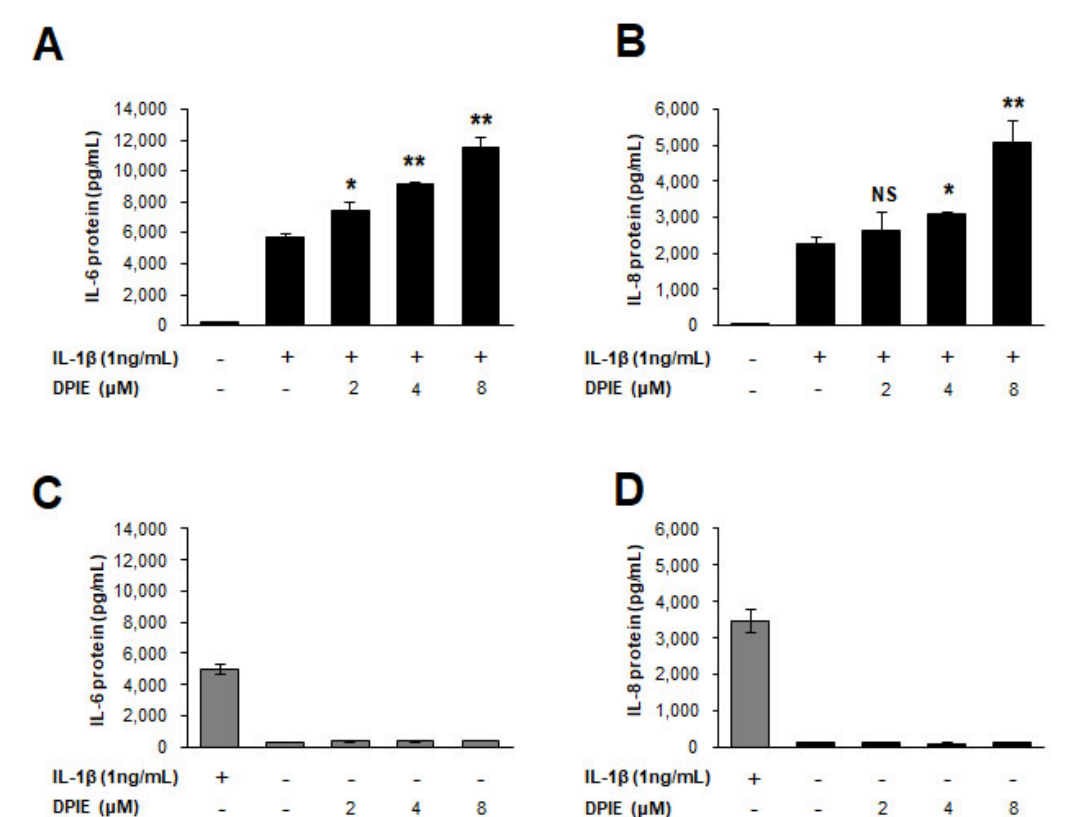
Figure 3. DPIE enhances pro-inflammatory cytokine secretion in IL-1 β -stimulated human gingival fibroblasts (hGFs). hGFs were treated for 12 h with 0, 2, 4, or 8 μ M DPIE in the absence or presence of 10 ng/mL IL-1 β , and the supernatants were analyzed using ELISA to detect the presence of IL-6 and IL-8. Concentration-dependent enhancing effects of DPIE on IL-6 protein ( A ) and IL-8 protein ( B ) produced in IL-1 β -stimulated hGFs. The effect of DPIE alone on IL-6 protein ( C ) and IL-8 protein ( D ) production in hGFs; * p < 0.05, ** p < 0.01; NS: not significant compared with IL-1 β alone (unpaired two-tailed Student’s t tests).